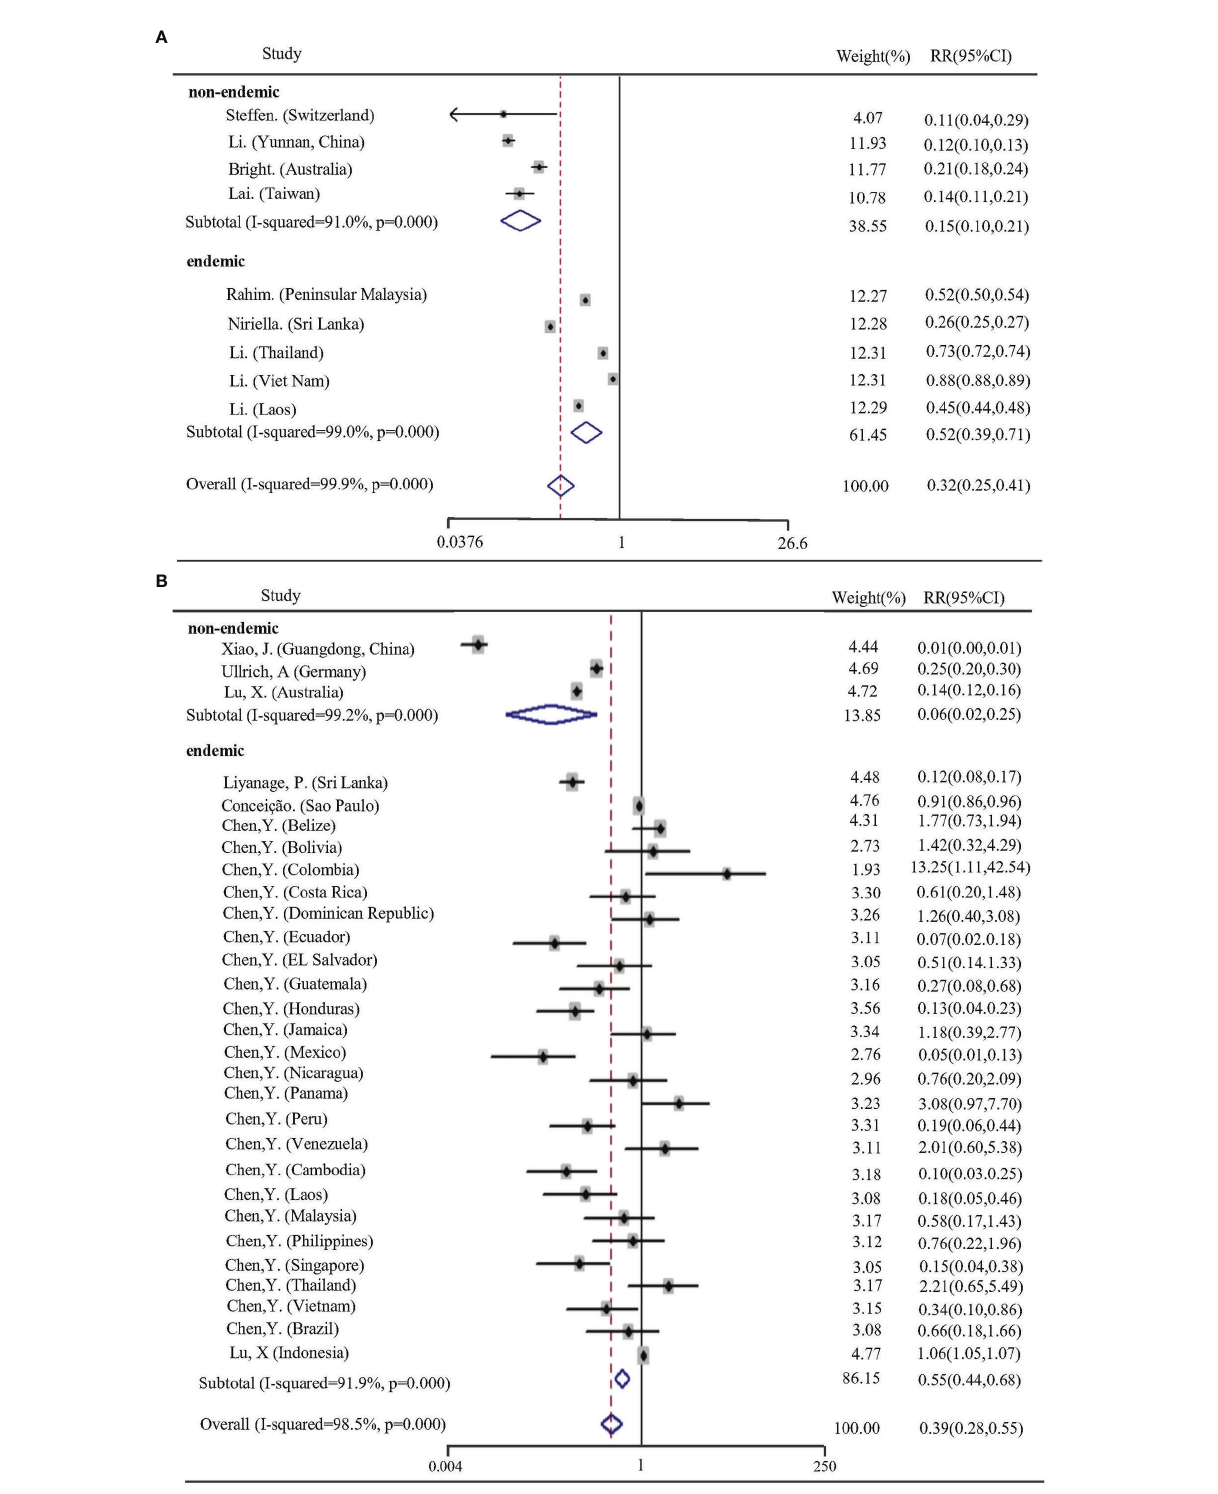
FIGURE 2 | Forest plot of pooled RRs for the effects of NPIs on dengue infection in 2020. (A, B) correspond to different statistical analysis groupings described above. RRs are random-effects estimates calculated by Mantel-Haenszel